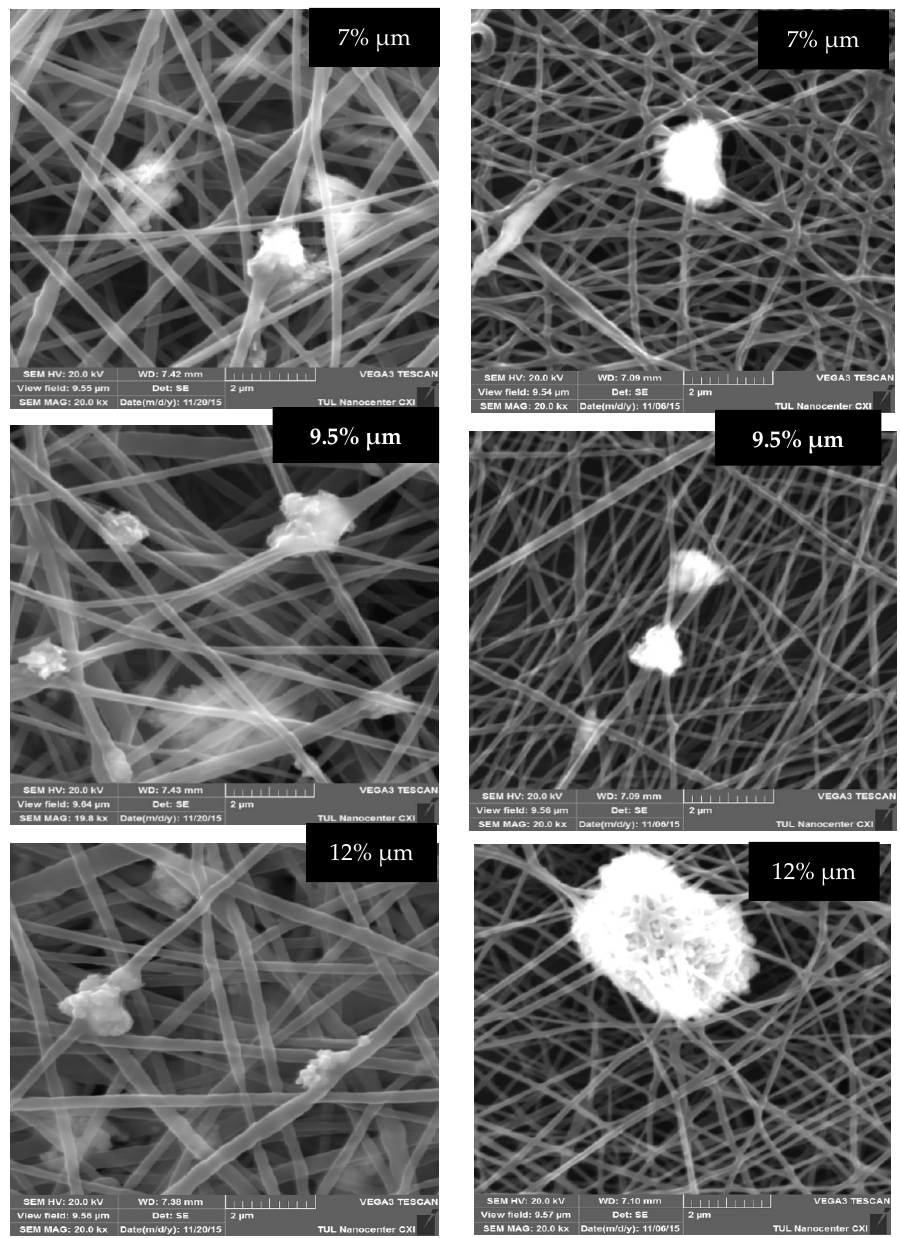
Figure 3. SEM images (20,000 × magnification) of composite nanofibers produced from both elec- trodes with different concentrations of CuO microparticles.